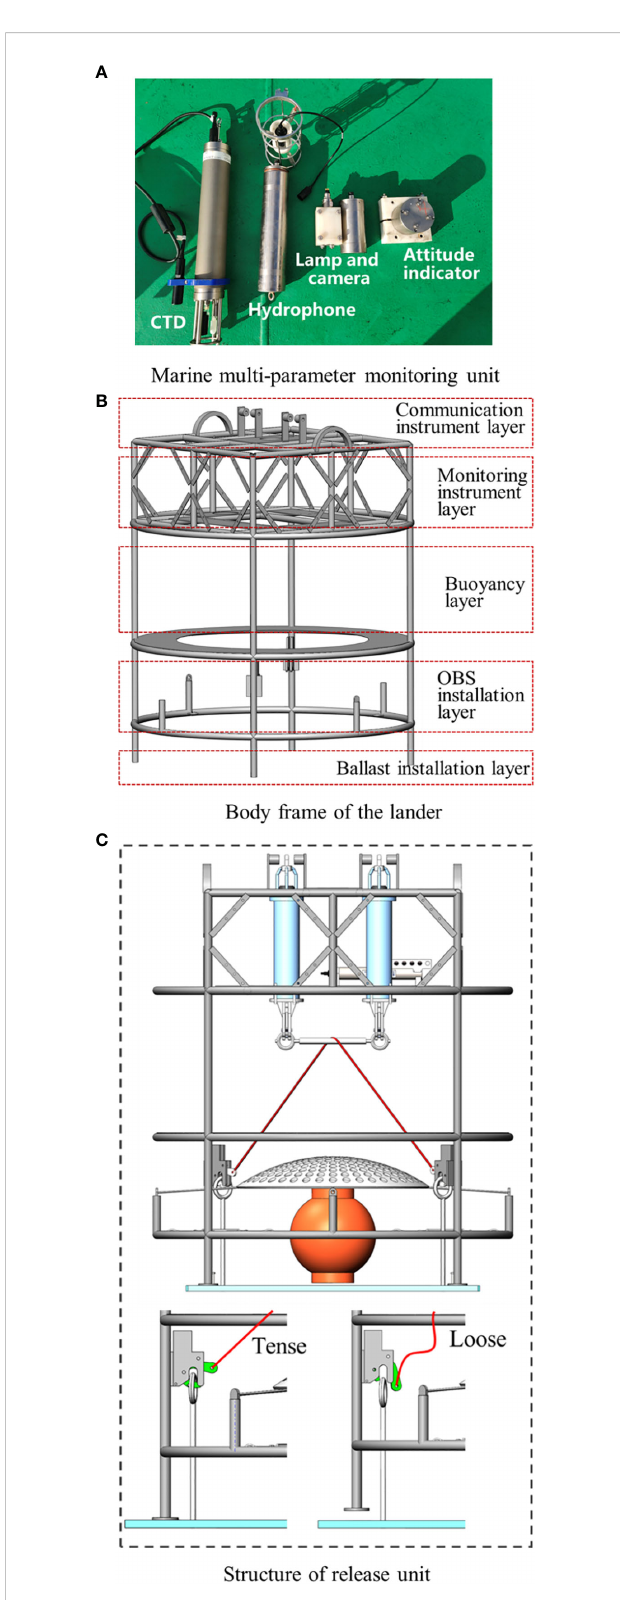
FIGURE 2 Parts of the lander. (A) Marine multi-parameter monitoring unit; (B) Body frame of the lander; (C) Structure of release